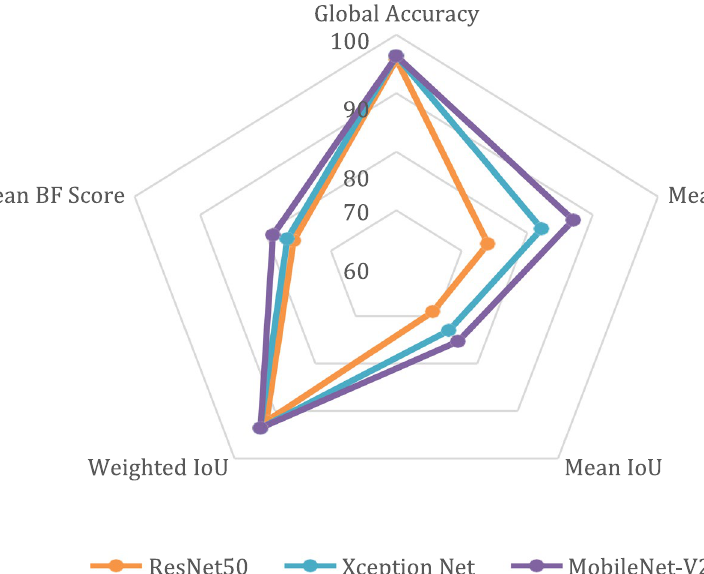
Fig. 12 The radar plot for each network for all the performance metrics for the testing dataset